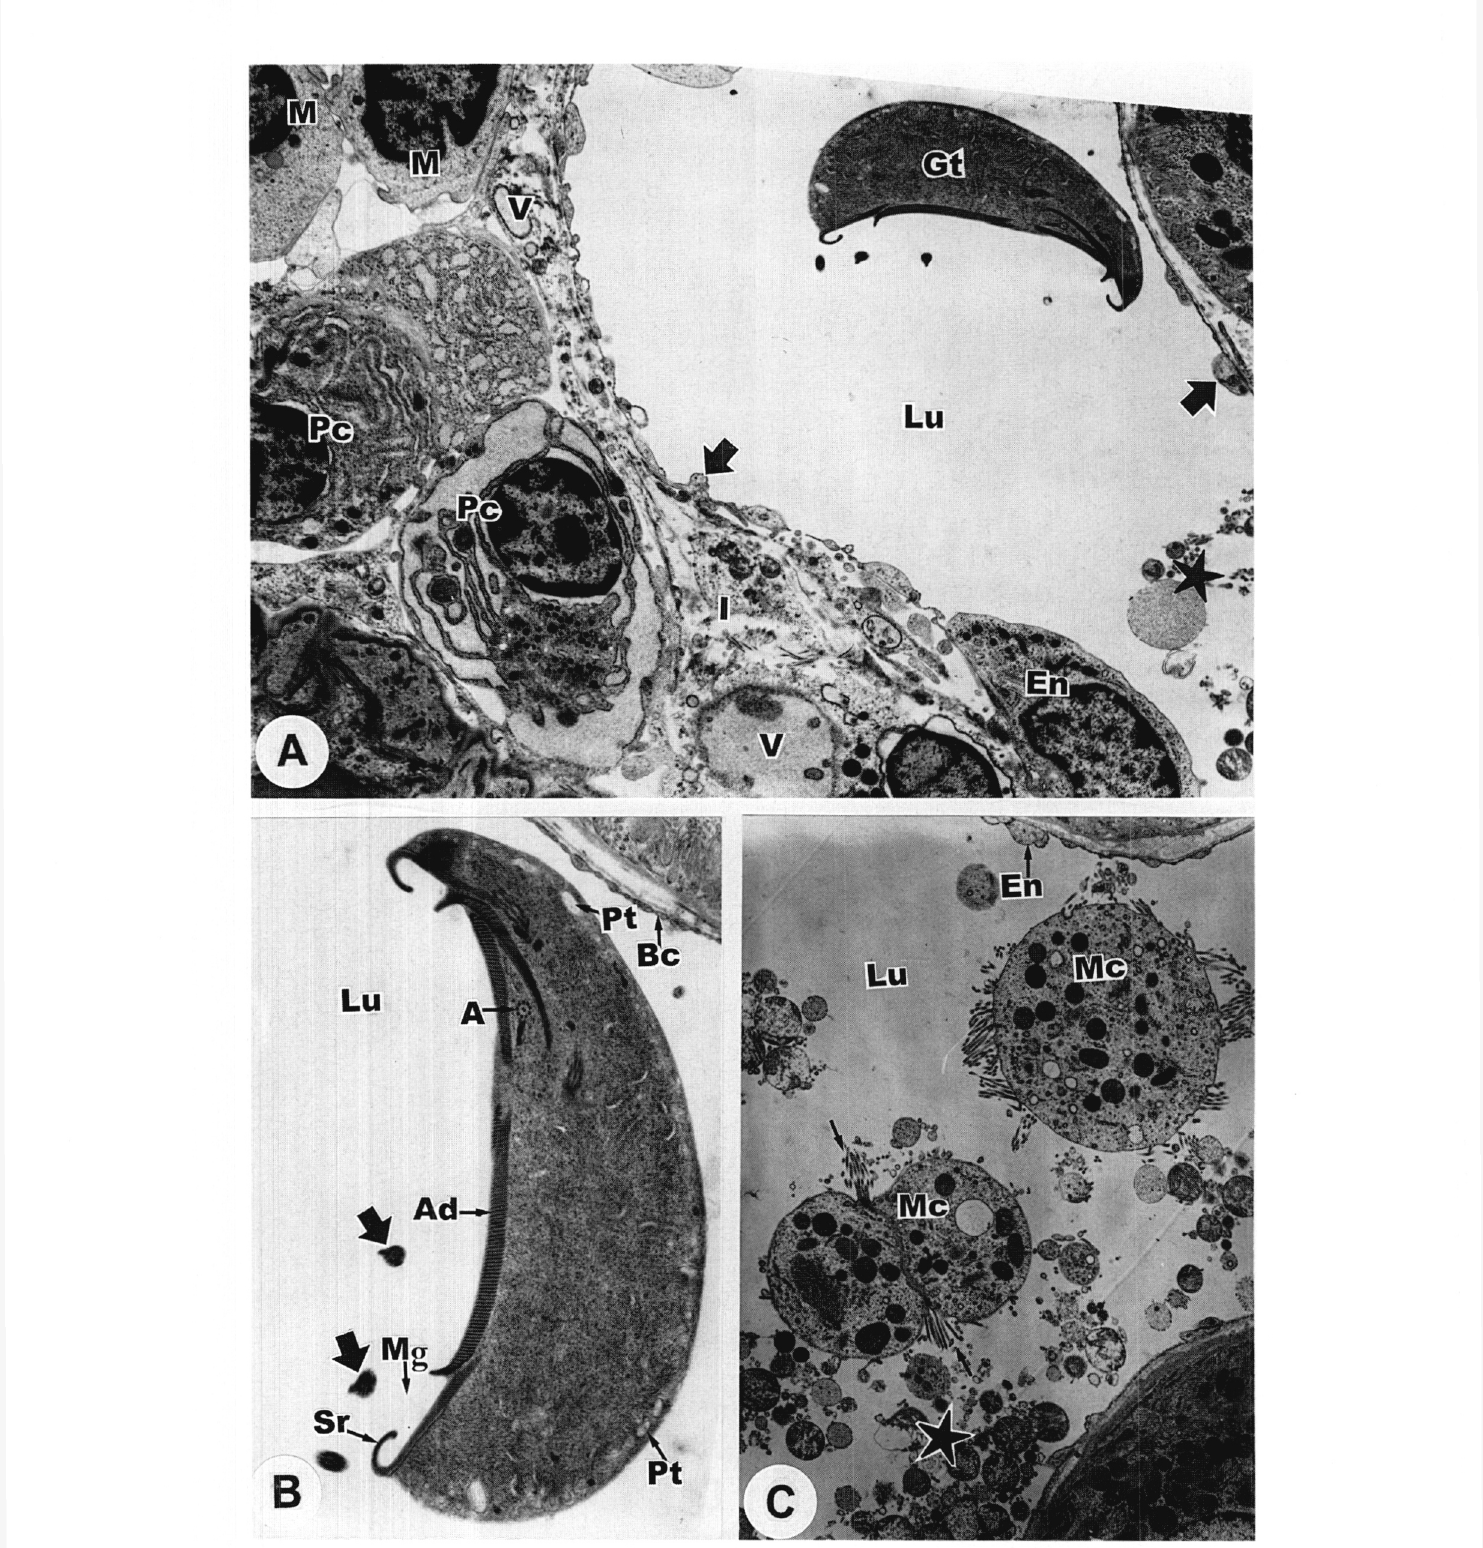
Fig. 2. - A: TEM photograph showing the lumen (Lu) of a blood capillary in the interstitium of renal tissue (I), with intra capillary Giardia trophozoite (Gt). Note accumulation of inflammatory cellular reaction including monocytes (M), active plasma cells (Pc). Endothelial cell (En) of blood capillary (thick solid arrows). Vacuoles (V). Star represents cellular organelles, x 5,500. - B: Higher magnification showing fine ultrastructures of Giardia trophozoite seen in A. Peripheral tubule (Pt). Axoneme of the ventral flagellum (A). Adhesive disc (Ad). Marginal groove (Mg). Striated rim of the groove (Sr). Flagellae (thick solid arrows). Blood capillary (Bc), x 11,400. - C: TEM photograph demonstrating two sized small and large macrophages (Mc). Small macrophage appeared dividing with two desmosomes (small arrows) inside a renal blood vessel (Lu). Endothelium of blood vesel (En). Star represents fragmented cellular organelles, x 4,700.